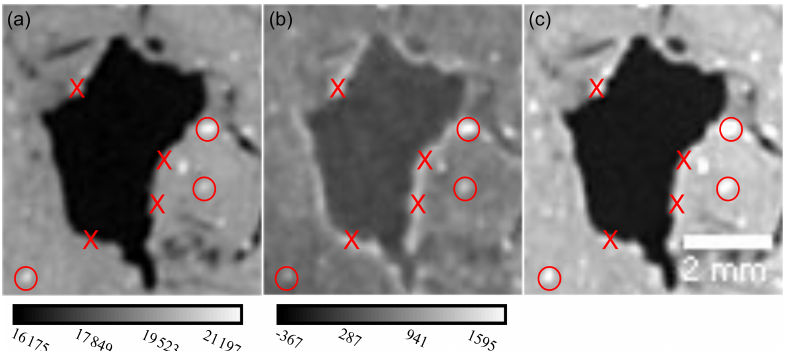
Figure 6. Magnification of a macropore from SNO1. Reference image (a) , difference image (b) and the image of Ba 2 + -treated soil (c) . The X and the circle indicate the identical coordinates in the images. Note that the reference image and image of Ba 2 + -treated soil share the same grey value calibration